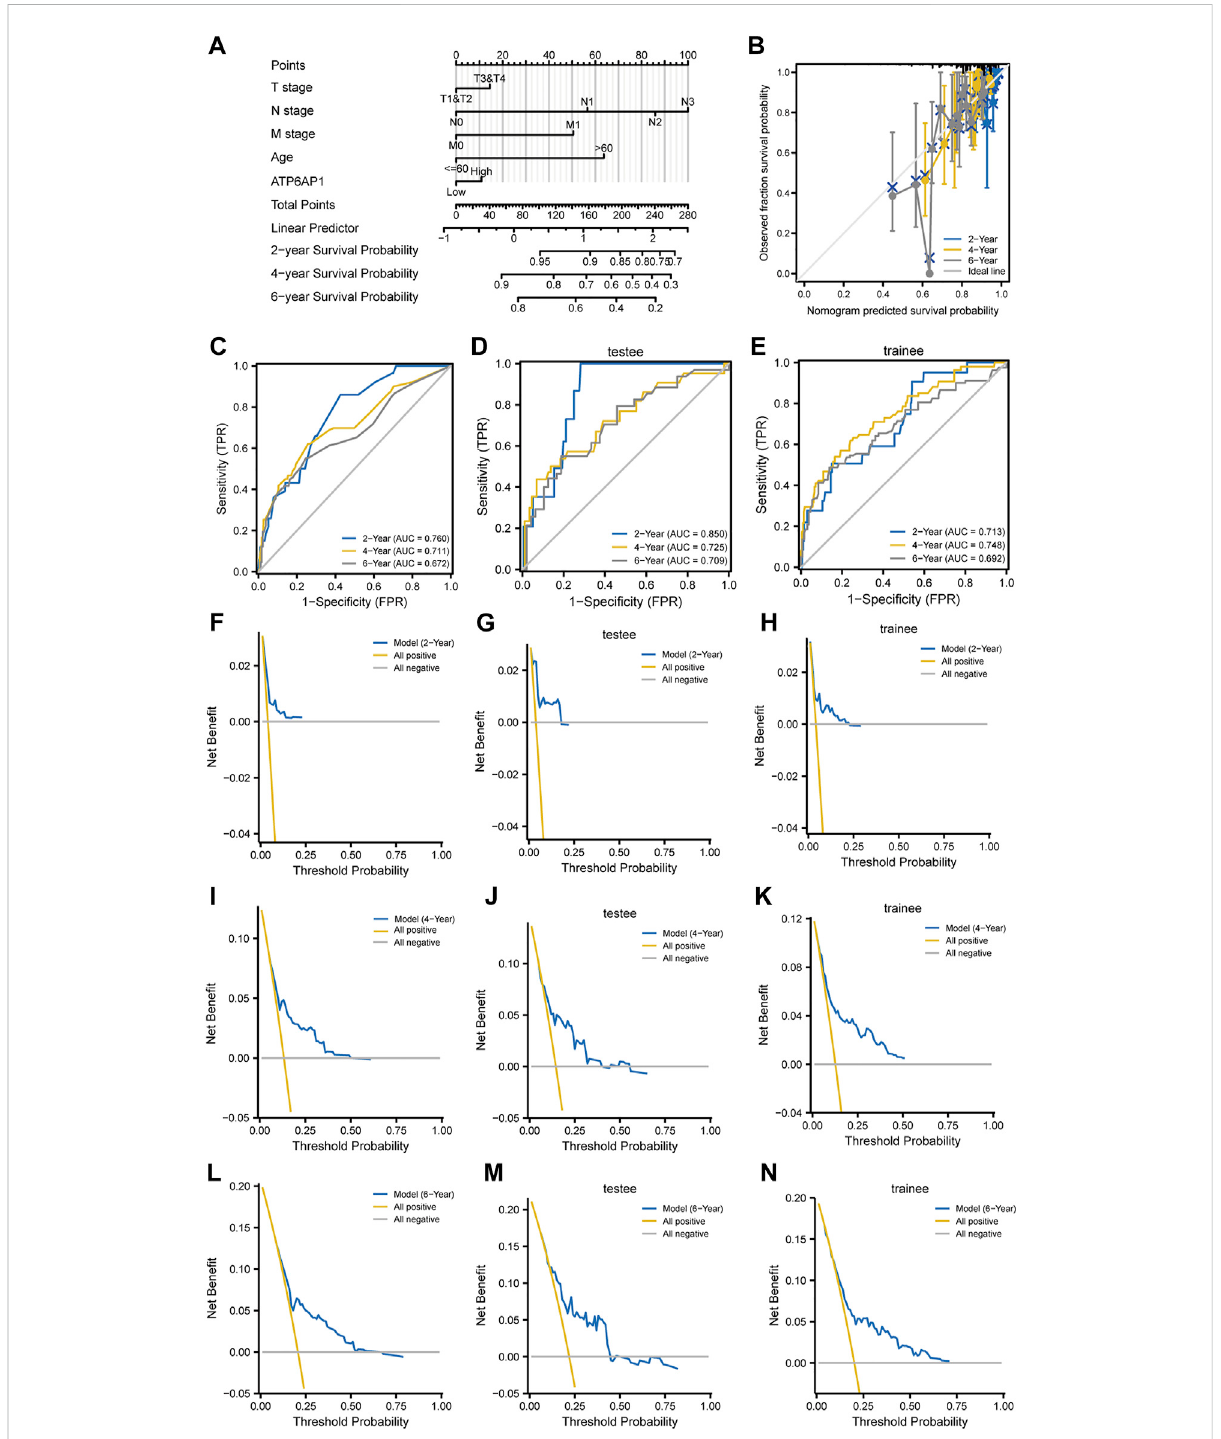
FIGURE 9 Construction of a prognosis model. (A) Breast cancer patients ’ 2-, 4-, and 6-year survival probabilities were predicted using a nomogram. (B) A nomogram calibrationplotforforecastingsurvivalprobabilityattwo,four,and6 years. (C – E) ROCcurvebasedonthenomogram prognosticmodel and ROC curves based on trainee and testee groups. (F – N) DCA curves based on the nomogram prognostic model and DCA curves are based on trainee and testee